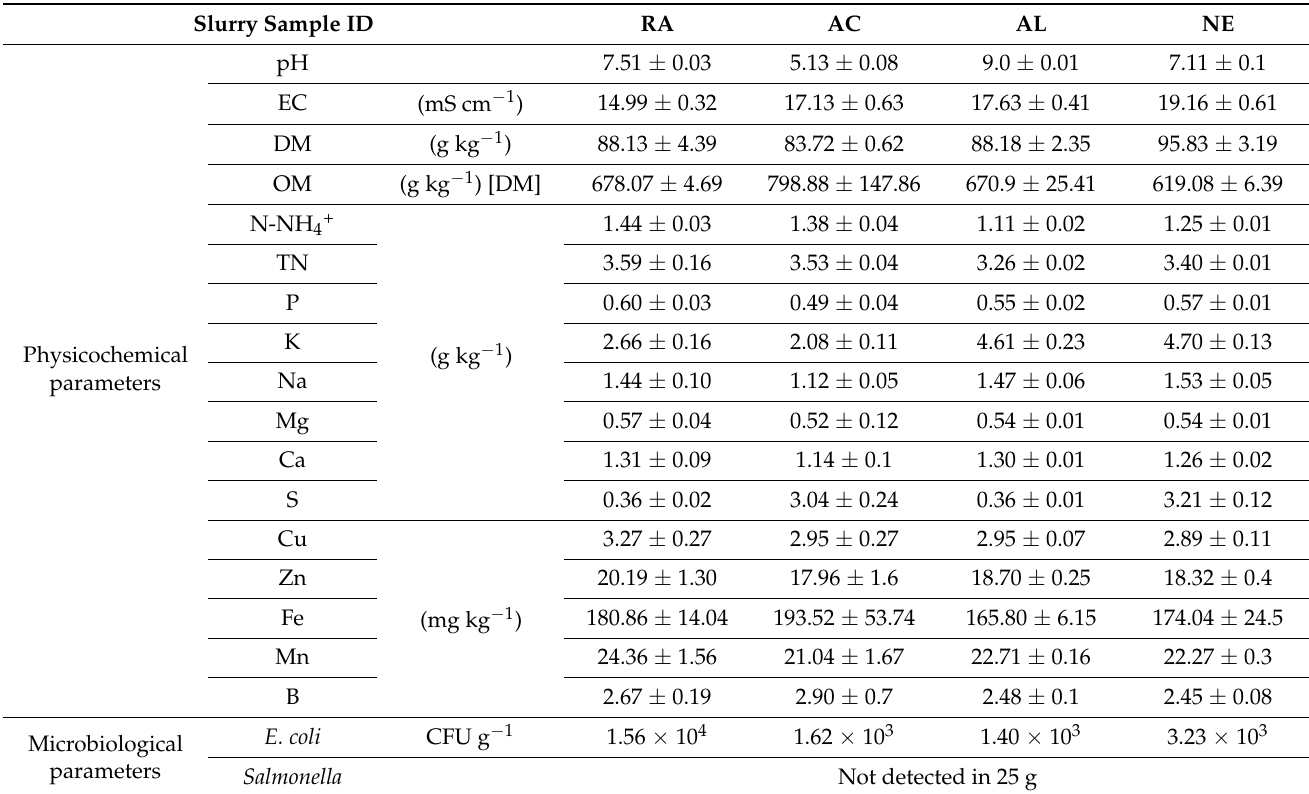
Table 2. Physicochemical and microbiological parameters of raw and treated dairy slurries used in the leaching test (Mean values, n =